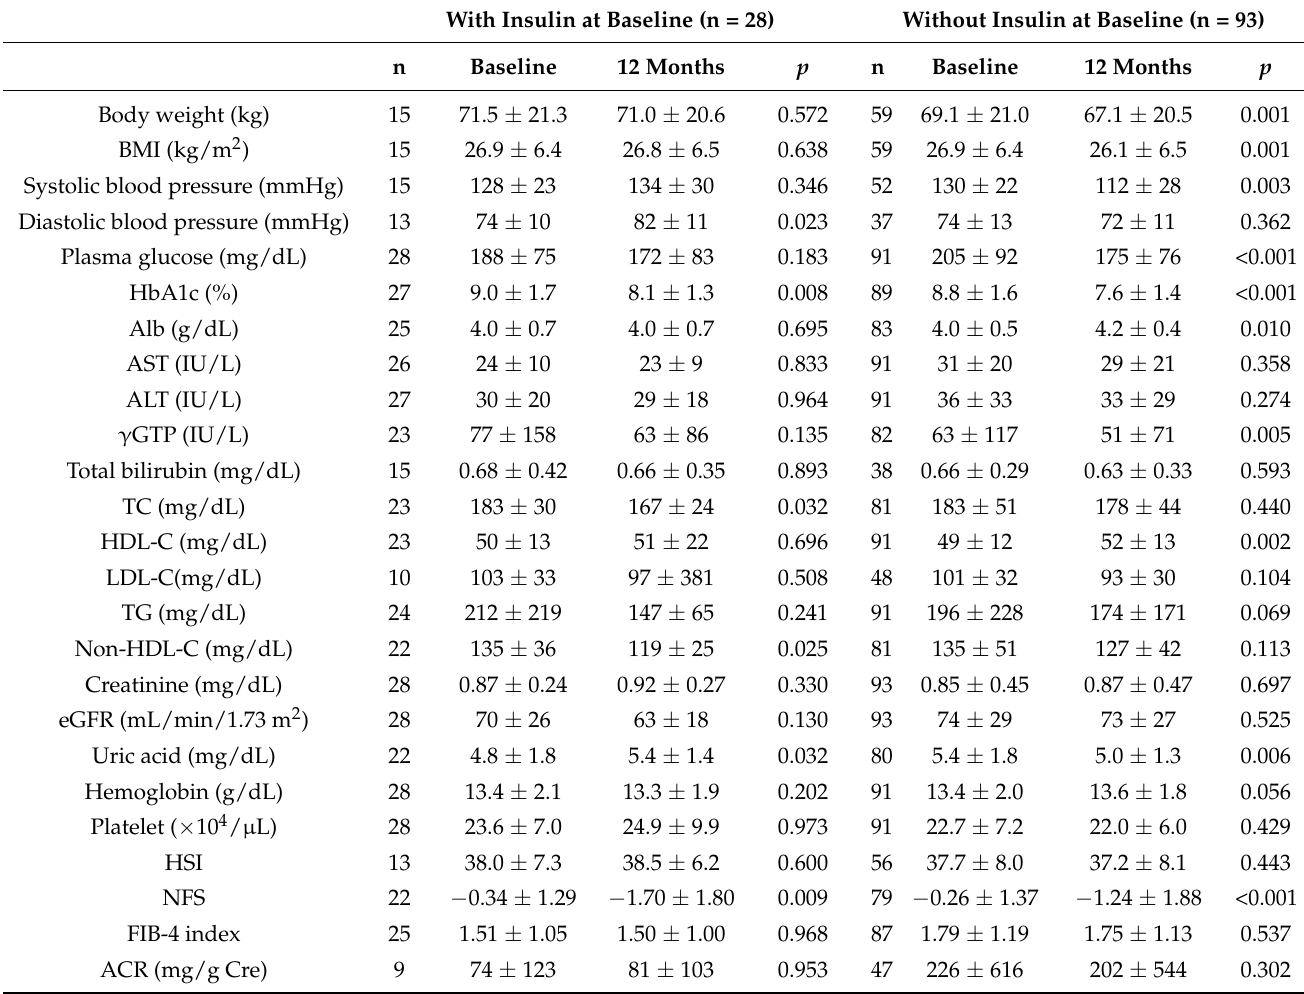
Table 5. Change in the clinical parameters 12 months after the start of dulaglutide in the subgroups with or without insulin treatment at